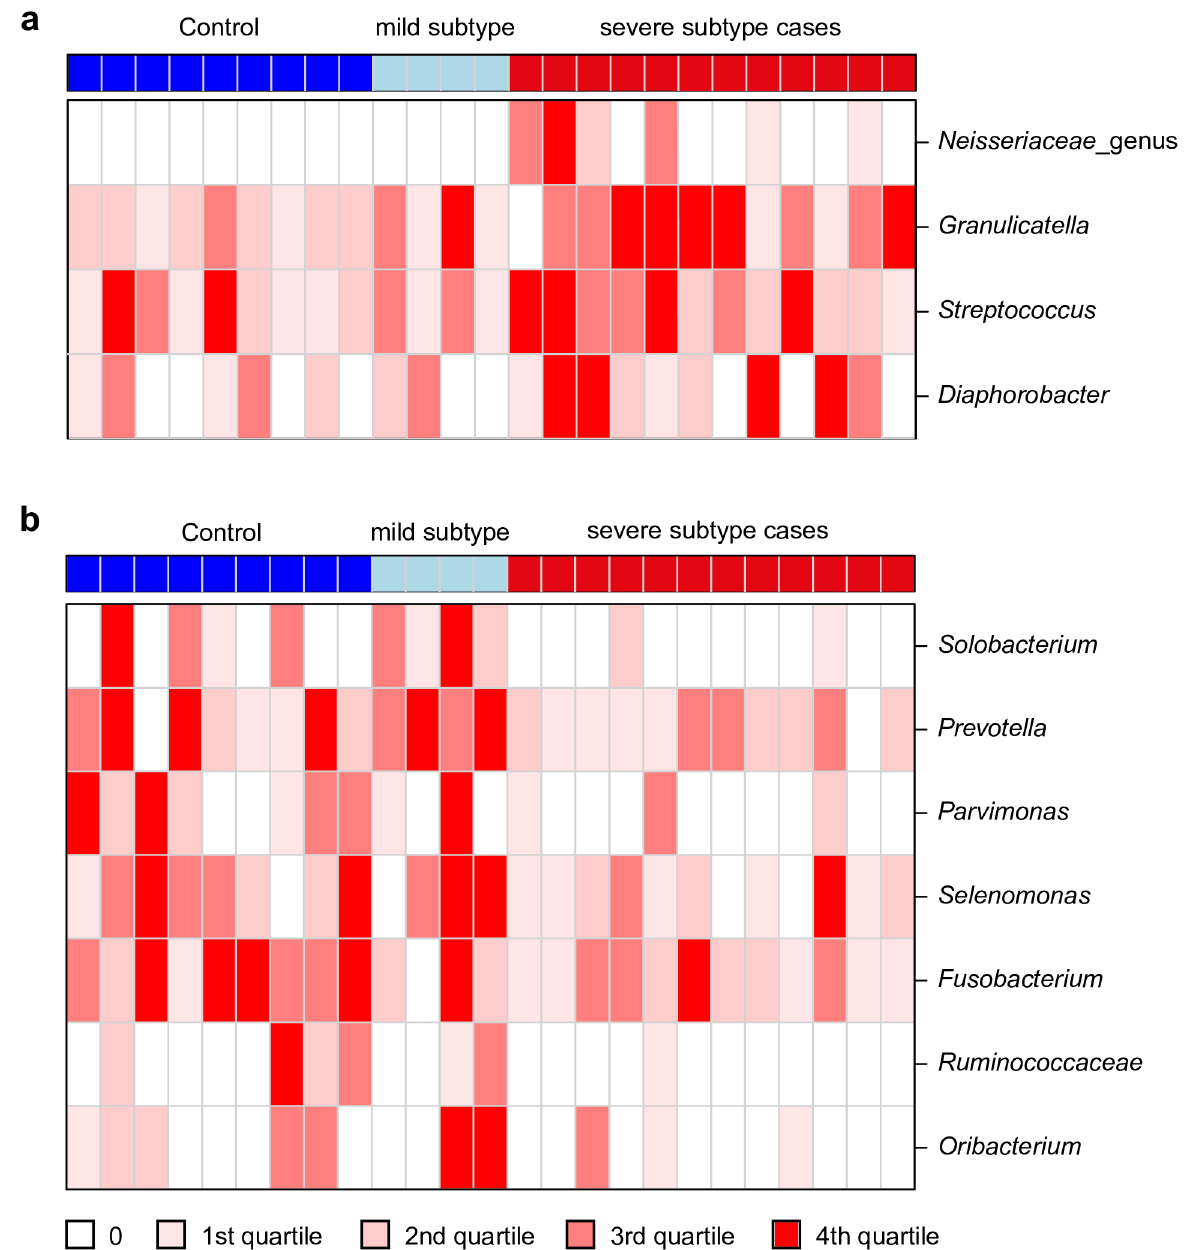
Fig 3. Heatmapof genera showing significantly different abundances between severeversus mild subtype cases and controls. Genera showingsignificantly increased( a ) or decreased ( b ) abundances in severe vs mild subtype cases and controls. Colors at the top represent COPD subtypes and controls. For each genus, samples were coloredbased on quartilesof non-zero abundancesfrom light red to dark red. All Samples for which a genus was not present were colored in